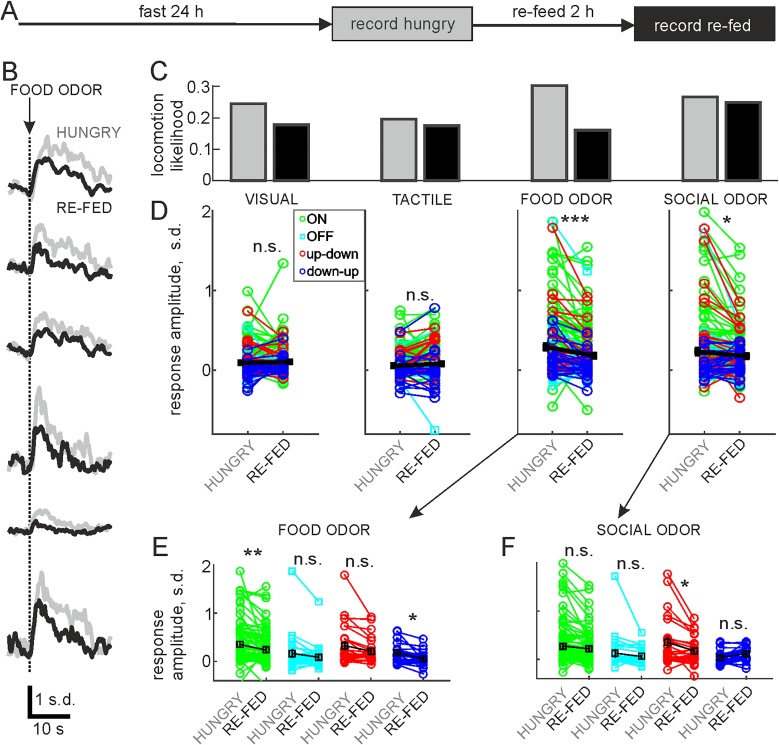
HON sensory responses are state dependent.A, Recording schedule for comparing sensory responses in hungry and re-fed animals. B, Example responses to food odor from six cells in hungry (gray) and re-fed (black) conditions. C, likelihood of initiating a locomotion bout following sensory stimulus across all four mice. D, Mean responses from trials where mice remained stationary, measured from an analysis window 1–4 s after sensory stimulus onset, colour coded by cell type as shown in legend. Overall mean responses in black (hungry response ± s.e.m., re-fed response ± s.e.m., P-value: visual 0.093 ± 0.014, 0.101 ± 0.015, P = 0.49; tactile 0.054 ± 0.012, 0.079 ± 0.016, P = 0.03; food odor 0.291 ± 0.032, 0.181 ± 0.023, P = 10−8; social odor 0.233 ± 0.033, 0.174 ± 0.022, P = 0.003). E, Responses to food odor from D by cell type according to legend in D (mean ± s.e.m. values in black: ON 0.34 ± 0.04, 0.24 ± 0.04; OFF 0.15 ± 0.08, 0.08 ± 0.04; up-down 0.32 ± 0.07, 0.21 ± 0.06; down-up 0.18 ± 0.04, 0.06 ± 0.05). F, Responses to social odor from D by cell type according to legend in D (mean ± s.e.m. values in black: ON 0.28 ± 0.04, 0.21 ± 0.04; OFF 0.012 ± 0.07, 0.06 ± 0.04; up-down 0.32 ± 0.10, 0.17 ± 0.06; down-up 0.04 ± 0.02, 0.11 ± 0.03). In D–F, n.s. P > 0.0125, * P < 0.0125, ** P < 0.001, *** P < 10−7.